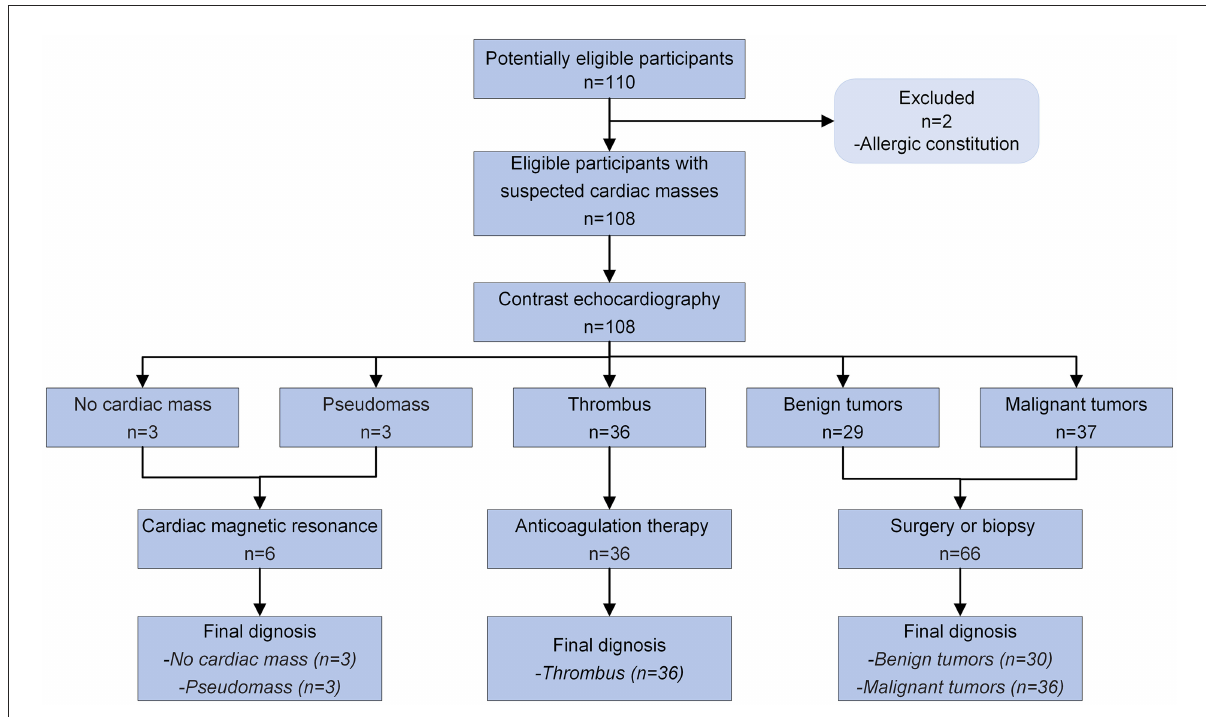
FIGURE2 Diagnostic flow diagram for patients with suspected cardiac masses using contrast echocardiography according to STARD 2015.